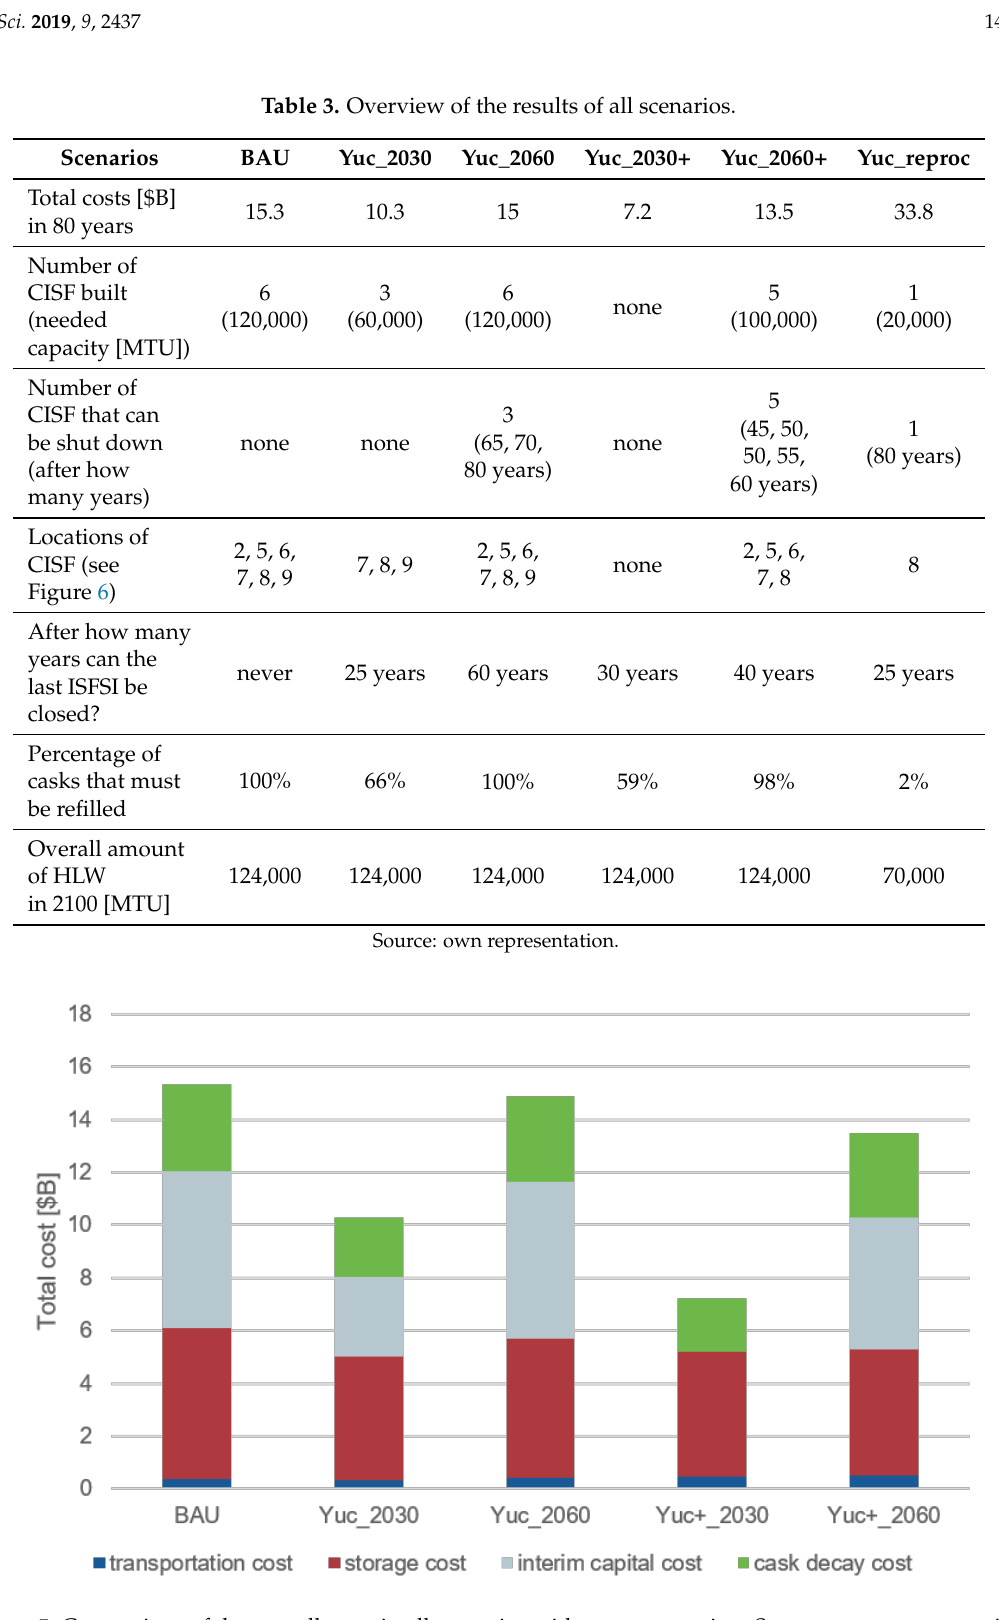
Figure 5. Comparison of the overall costs in all scenarios without reprocessing. Source: own